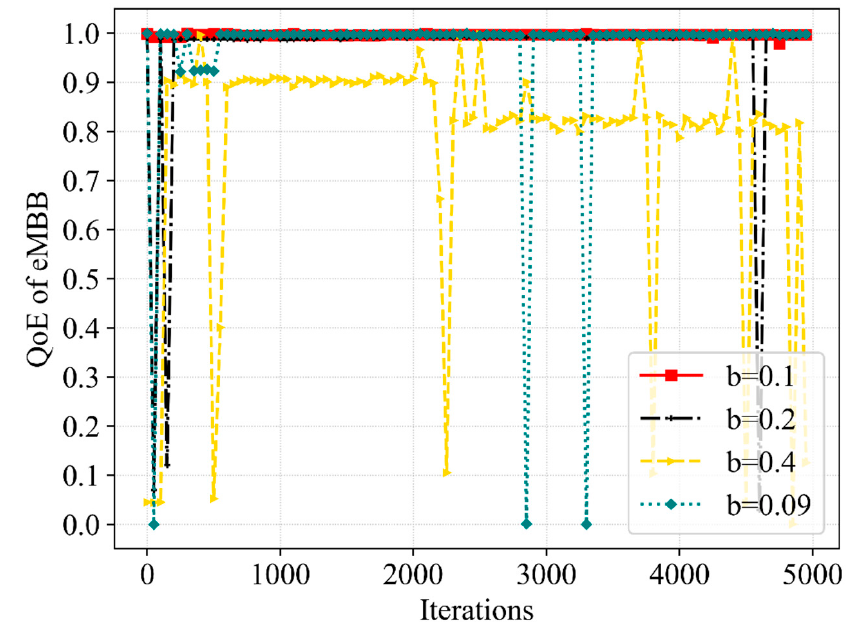
Figure 11. A comparative result of QoE for eMBB service at various 𝑏